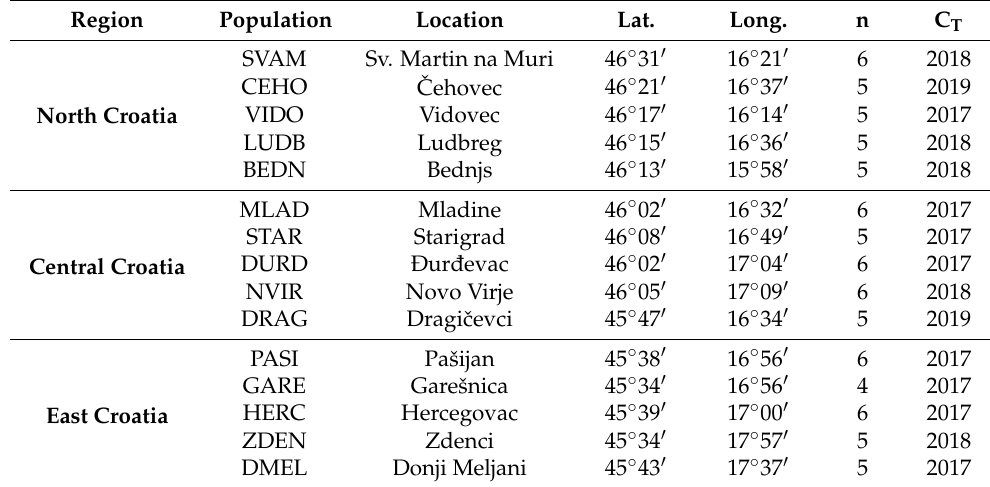
Table 1. The sample information of Colorado potato beetle populations in Croatia. and agarose gel electrophoresis (1% with GelGreen Nulceid Acid Stain–Biotium). Extracted DNA was sent to Diversity Array Technology, Australia, for sequencing and genotyping using DArTseq TM genotyping technology [55]. Region Population Location Lat.